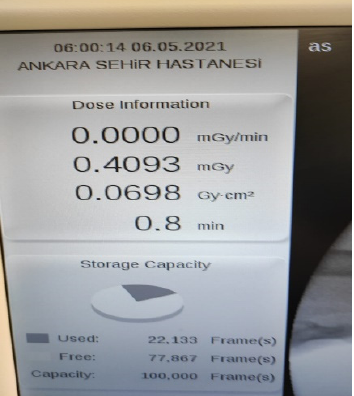
Figure 4. Radiation duration and dose recorded via fl uoroscopy.